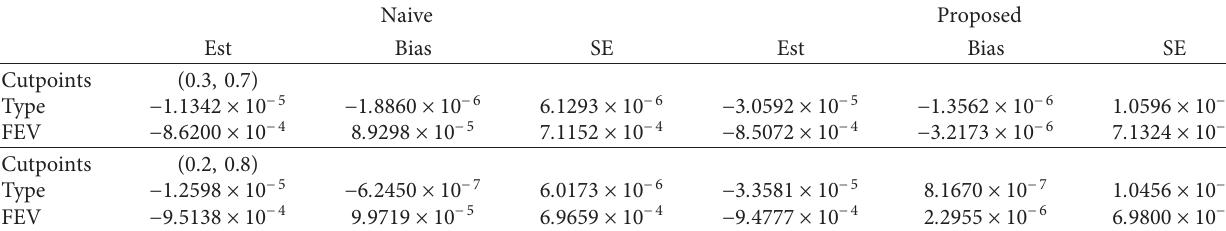
Table 5: Results for analysis of pulmonary exacerbation study data. Naive